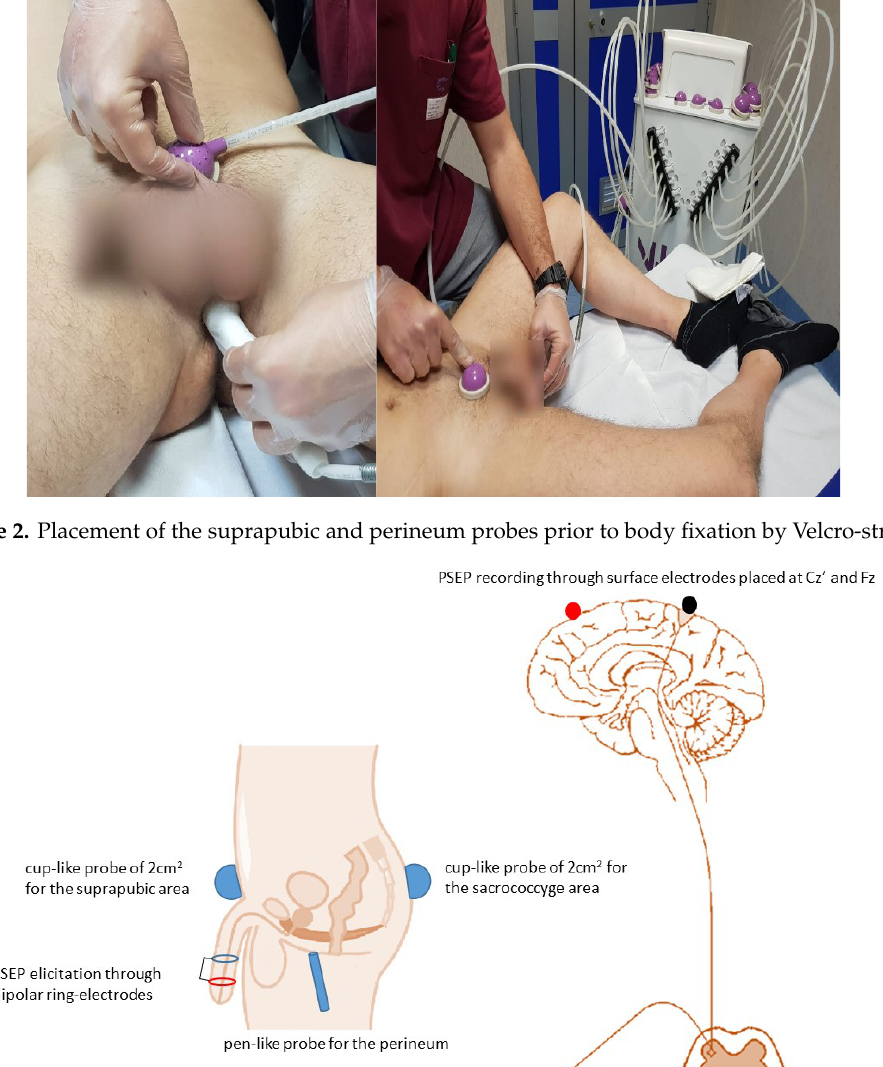
Figure 3. Placement of the probes and pudendal nerve somatosensory-evoked potential (PSEP) setup.